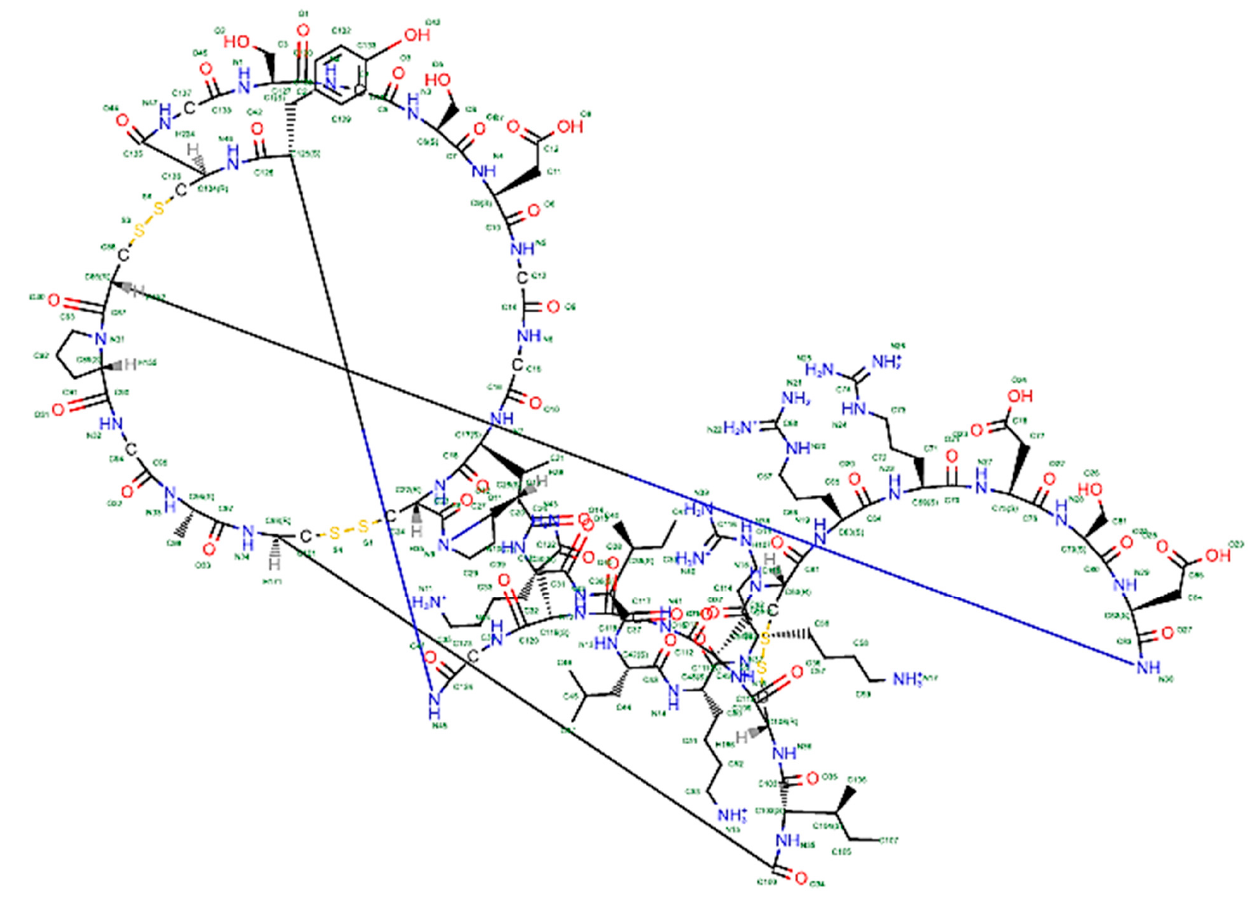
Figure 2. 2D representation of a typical knottin peptide, a cyclic protease inhibitor (Trypsin inhibitor, MCoTI-II) isolated from the seeds of an important medicinal plant, Momordica cochinchinensis (Cucurbitaceae). This gene encoded cyclotide is abundantly expressed at the peptide level. The two nearly parallel disulfide bonds have been cross linked by a third one which passes through each of the two to form a knotted structural configuration that induces enormous stability in this bioactive knottin-like peptide. PDB:1HA9.